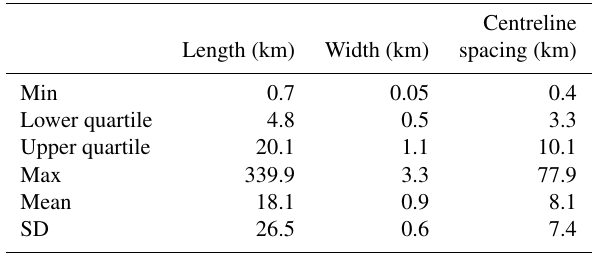
Table 1. Summary statistics for meltwater routes in the study area.